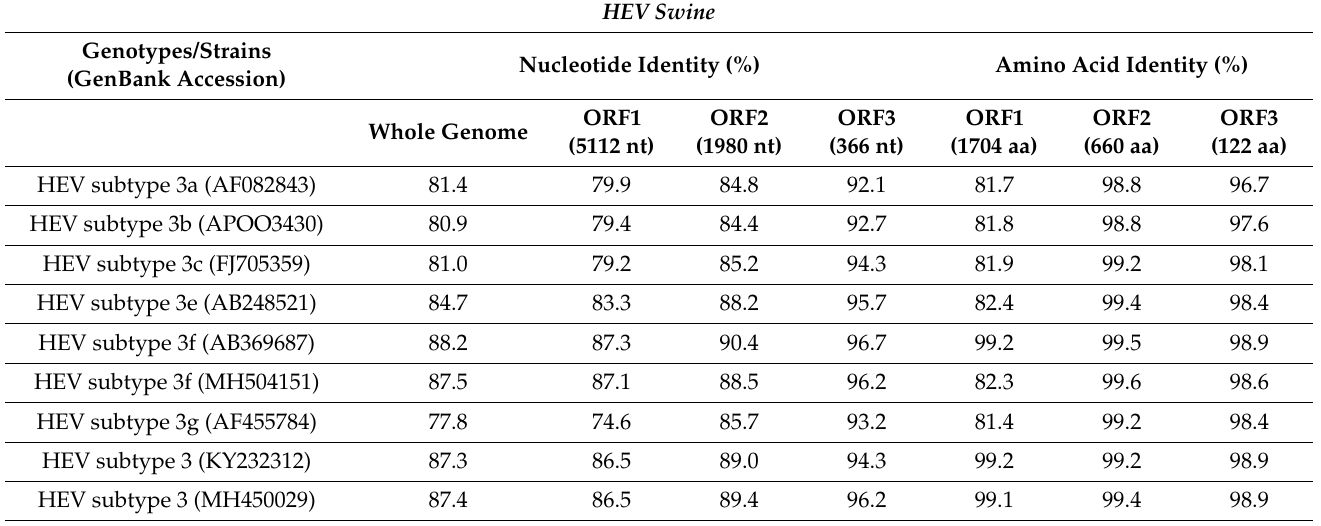
Table 1. (a) Comparison of the nucleotide and deduced amino acid sequences of local swine HEV-3 versus reported swine HEV-3 subtypes. nt—nucleic acids; aa—amino acids. (b) Comparison of the nucleotide and deduced amino acid sequence identities of local camel-derived HEV-7 versus reported camel HEV-7.